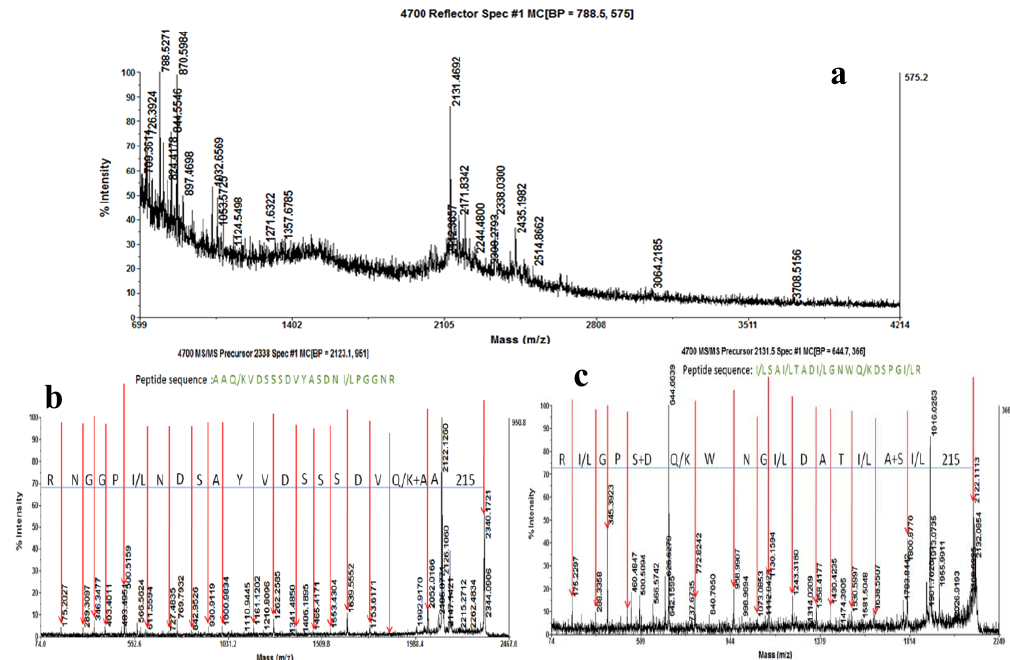
Figure 3. Peptide mass fingerprinting (PMF) and amino acid sequence of GBSP. ( a ) The MALDI-TOF spectrum of GBSP; ( b ) the amino acid sequence of the 2131 Da peptide; ( c ) the amino acid sequence of the 2338 Da